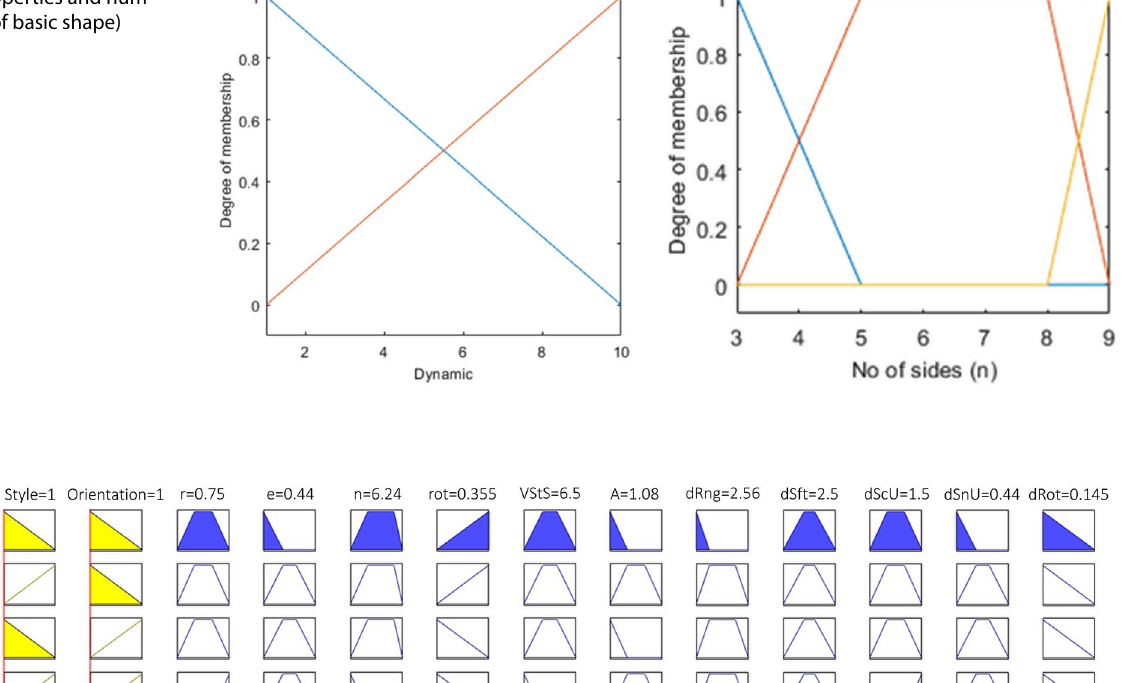
Fig. 8 Membership functions (dynamic properties and num- ber of sides of basic shape)